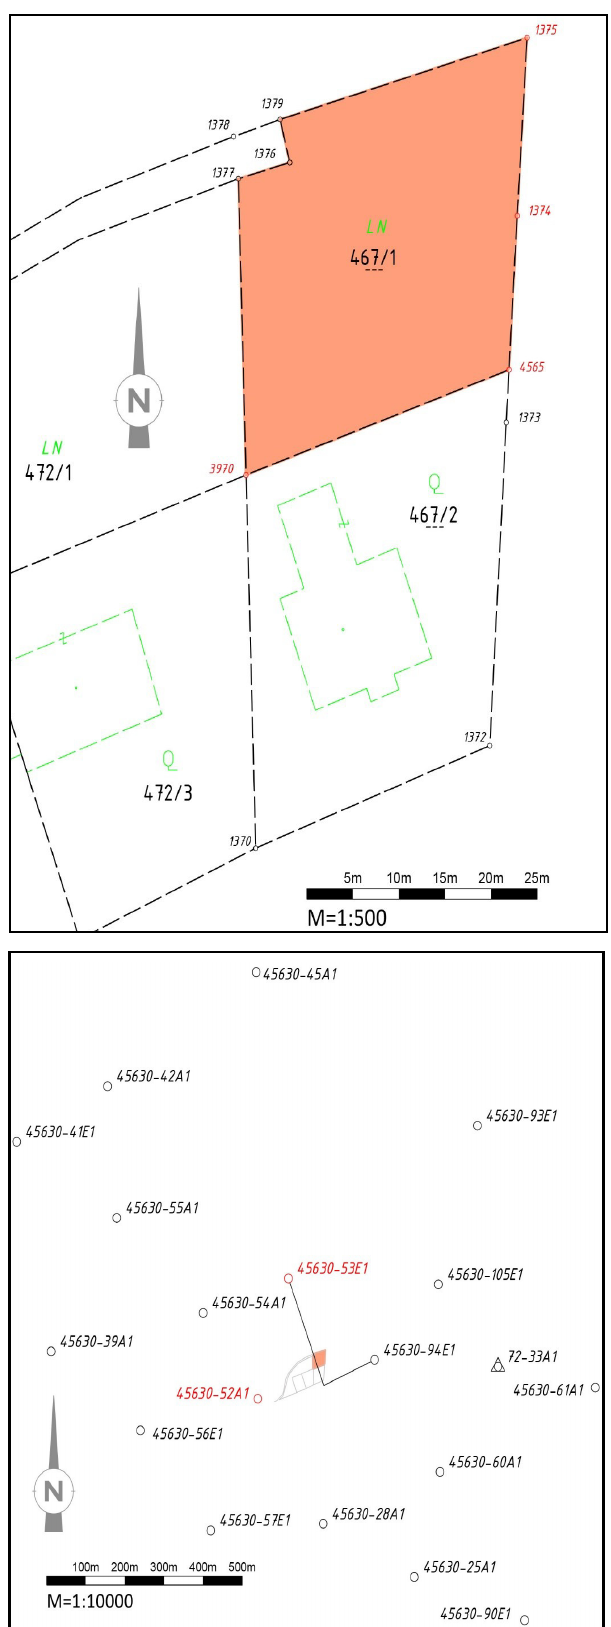
Figure 6. Cadastral maps showing the affected parcel. Boundary marks that have been found in the real world are plotted in red ( top ). Overview of the control point network including the traverse used to survey the parcel ( bottom